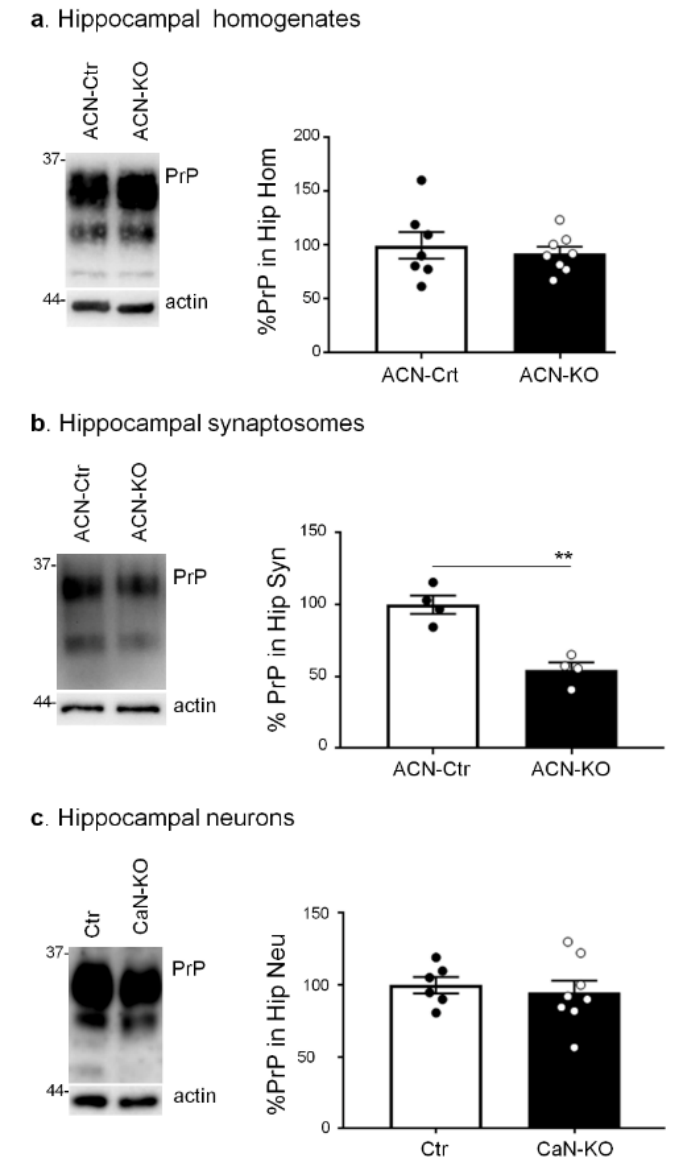
Figure 3. Analysis of PrP C expression in hippocampal tissues from ACN-Ctr and ACN-KO mice at one month of age. ( a ) WB analysis with anti-PrP and anti-actin antibodies of hippocampal homogenates from ACN-Ctr and ACN-KO mice. Quantification of the actin-normalized PrP signal expressed as percentage of Ctr. Data are the means ± SEM, ACN-Ctr n = 7, ACN-KO n = 8, unpaired t -test, ns. ( b ) Synaptosomal fractions from hippocampi of ACN-Ctr and ACN-KO mice were analyzed by WB with anti-PrP and anti-actin antibodies. Quantification of the actin-normalized PrP signal expressed as percentage of Ctr. Data are the means ± SEM, ACN-Ctr n = 4, ACN-KO n = 4, unpaired t -test, ** p = 0.0015. ( c ) WB analysis with anti-PrP and anti-actin antibodies of hippocampal neurons from ACN-Ctr (Ctr) and ACN-KO (CaN-KO) mice. Quantification of the actin-normalized PrP signal expressed as percentages of Ctr. Data are the means ± SEM, Ctr n = 6, CaN-KO n = 8, unpaired t -test, ns.